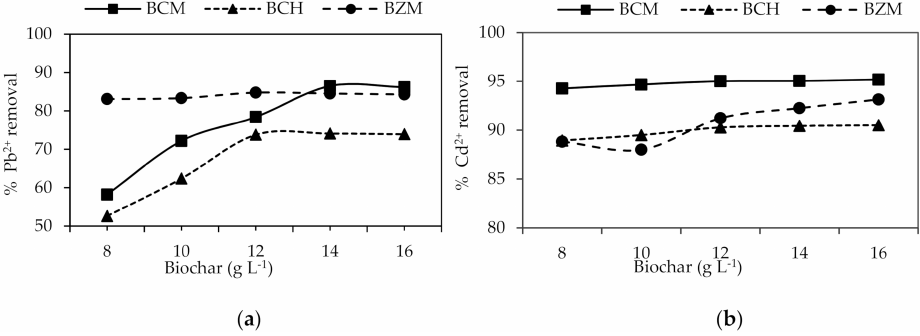
Figure 4. Removal percentage as a function of the biochar dose: ( a ) Pb 2 + and ( b ) Cd 2 + .